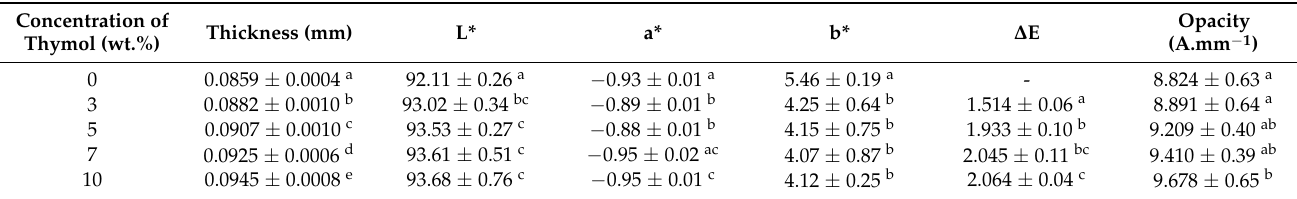
Table 1. Thickness, color parameters, and opacity of starch/CNF bionanocomposite films incorporated with different concentrations of thymol. Concentration of Thymol